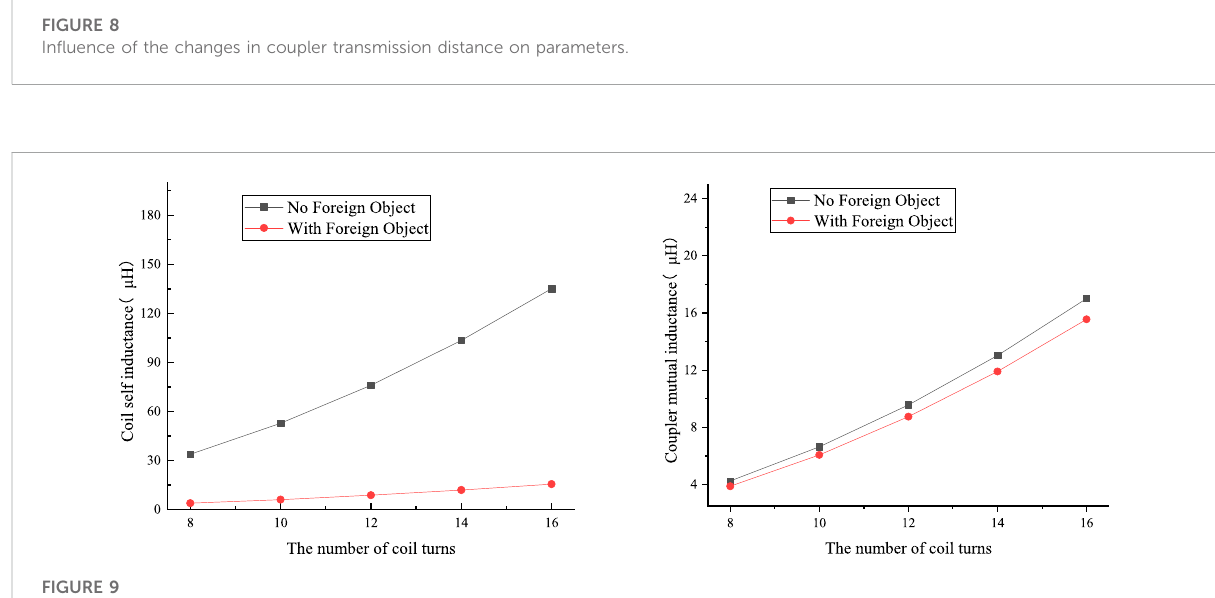
FIGURE 9 In fl uence of the changes in the number of coil turns on parameters.